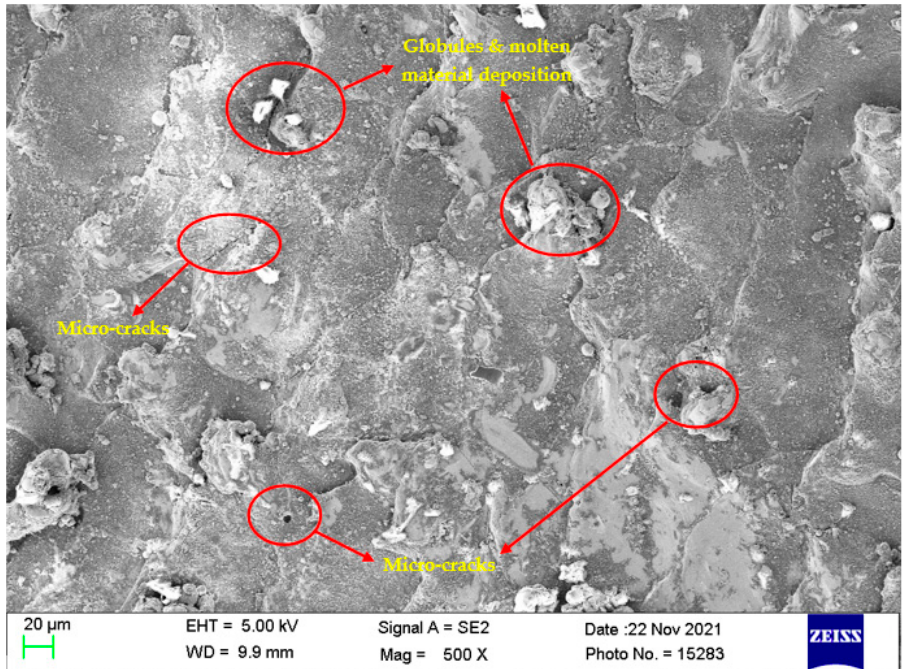
Figure 10. Surface morphology at T on = 31 µs, T off = 12 µs, and Al 2 O 3 amount = 2 g/L.